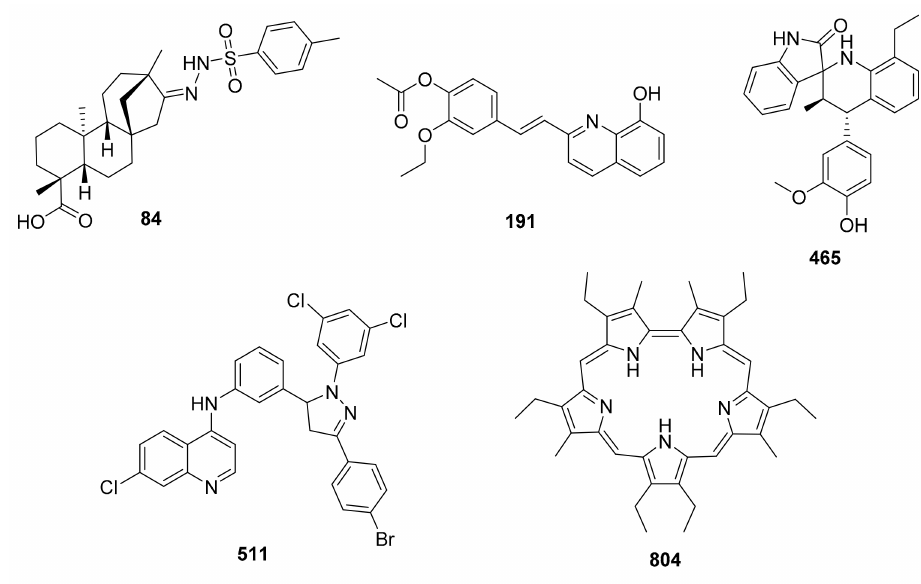
Figure 10. Chemical structures of the best antileishmanial candidates from Colombian